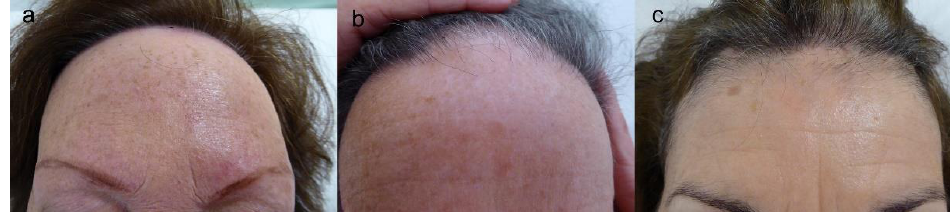
Figure 2. (a ) Pattern I: linear and uniform hairline recession, without loss of hair density behind the new hairline. ( b ) Patter II: diffuse alopecia behind the frontal hairline with loss of hair density behind. ( c ) Pattern III: unaffected primitive frontal hairline followed by an alopecic band, forming the pseudo “fringe sign”. Note the absence of eyebrow alopecia.